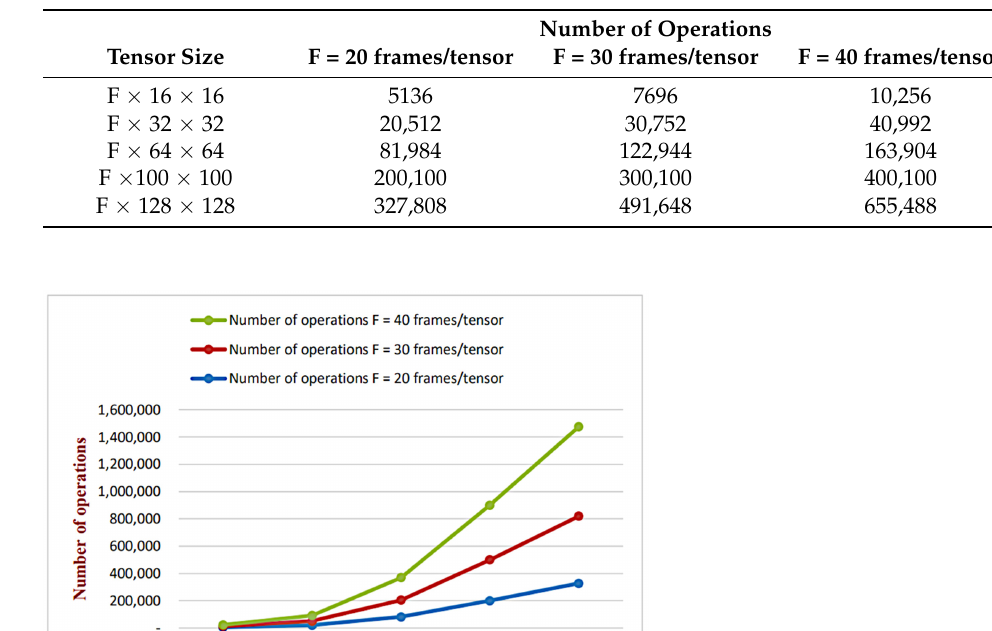
Table 4. The relation between number of operations and tensor size.